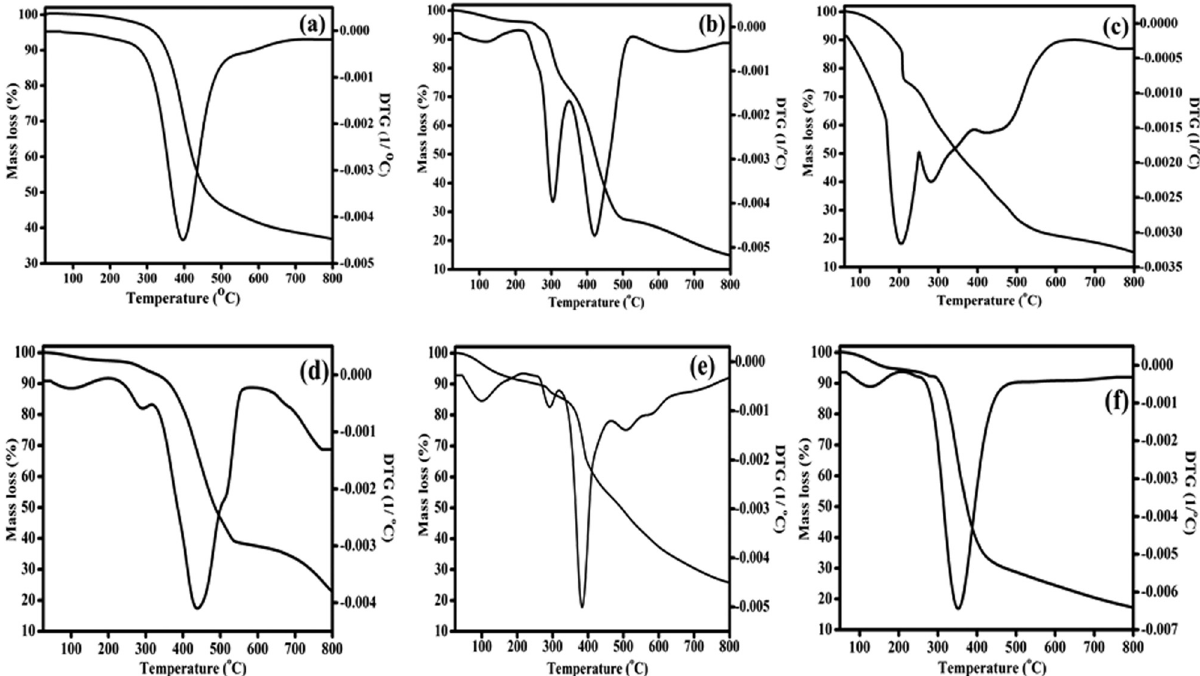
Figure 2: Simultaneous TG - DTG thermograms of ( a ) L, ( b ) [ CoL ( ac ) 2 ] , ( c ) [ NiL ( ac ) 2 ] , ( d ) [ CuL ( ac ) 2 ] , ( e ) [ CuL ( acac ) 2 ] , and ( f ) [ CuL ( fms ) 2 ] complexes in nitrogen